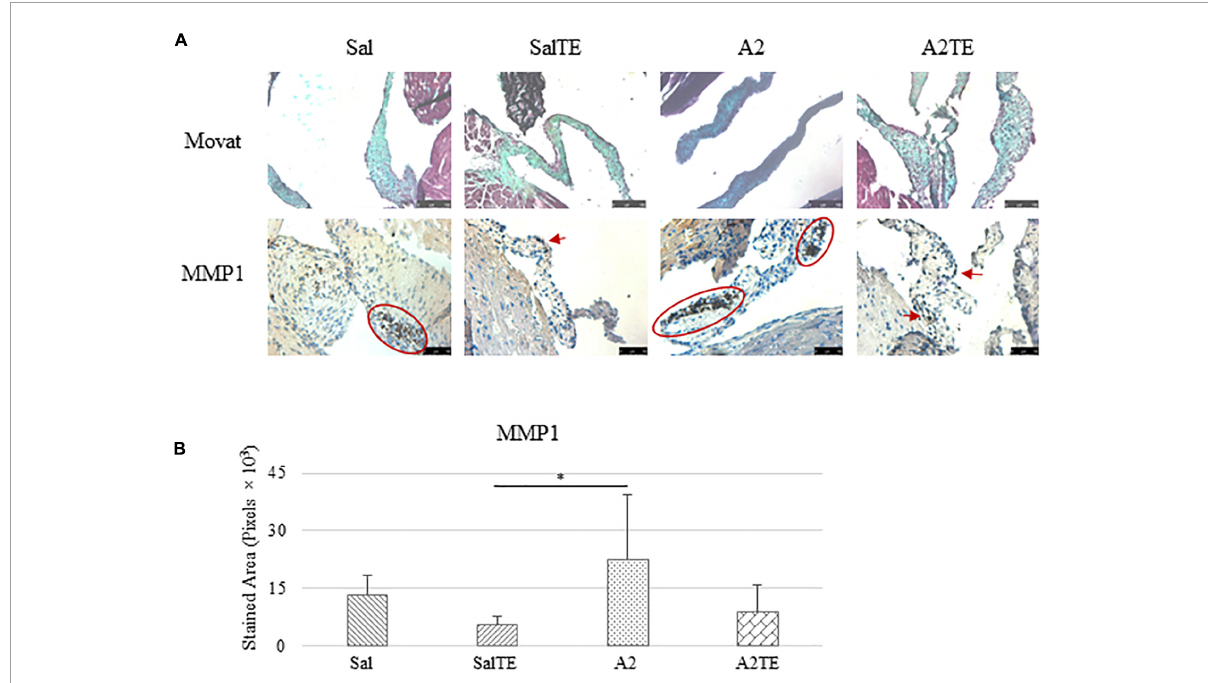
FIGURE5 (A) Investigation of mitral valve ECM remodeling by Movat stain and MMP1 IHC in prevention study. Major positive IHC stains were highlighted by circles and arrows. Scale bar on Movat images: 100 µ m. Scale bar on IHC images: 50 µ m. (B) Quantification of MMP1 expression determined by total stained area in pixels that measured from 4 biological replicates in MATLAB. Asterisk indicates significant difference ( p < 0.05).